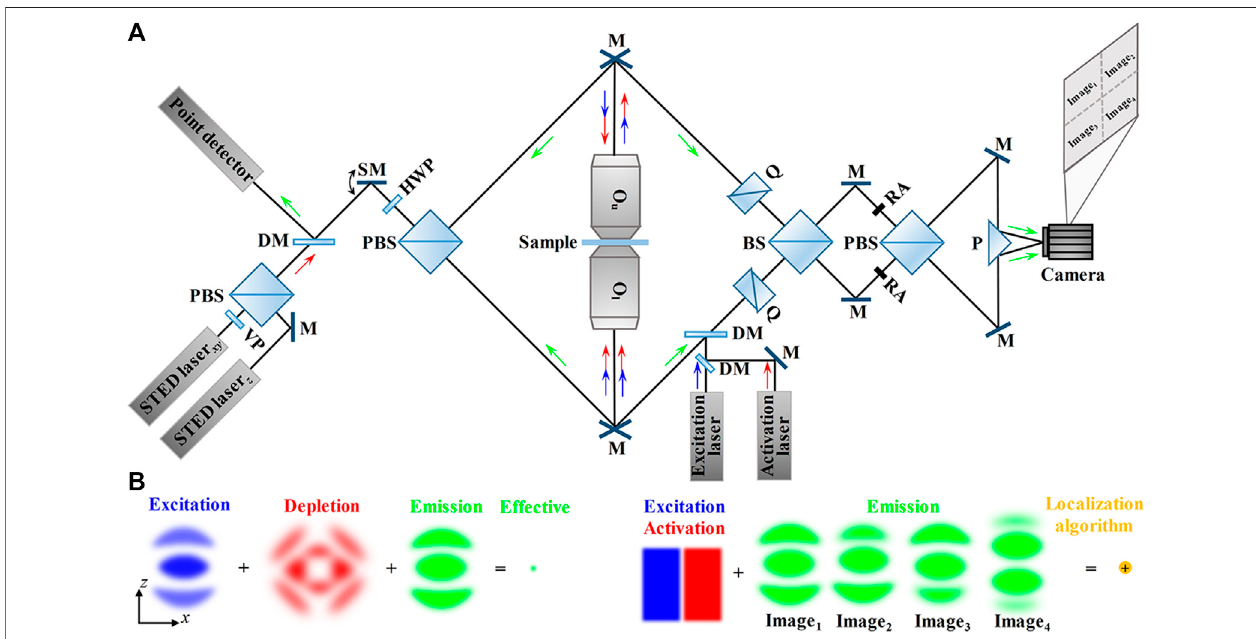
FIGURE6 | Schematic and principle ofdual-lens SRFM methods relying on nanoscopy. (A) Schematic of scanning modality (left, such as isoSTED/4Pi-RESOLFT) and wide fi eld modality (right, 4Pi-SMLM). Left: in isoSTED, the beams for STEDxy (lateral) and STEDz (axial) are combined by a polarizing beam splitter and then fed through ascanning mirror and asecond polarizing beam splitter into the4Picavity.The fl uorescence from the sampleis inversely collected by thesame objective lenses and re fl ected by a dichroic mirror, and fi nally collected by a point detector. Right: in 4Pi-SMLM, the synchronized excitation beam and activation beam are fed into the interference cavity sothat only individual fl uorescence molecules are brightat a time. The fl uorescence isdivided and recombined bya beam splitter and a polarizing beam splitter to create four interference patterns with different phases, and then, the four interference patterns are imaged by the four-quadrant camera simultaneously. (B) PSFsinisoSTED(left)and 4Pi-SMLM(right)intheaxial(xz)plane. Left:theisotropiceffective PSFisobtainedbythesuperimpositionofexcitation PSF,depletionPSF (the superimposition of STEDxy beam and STEDz beam), and emission PSF. Right: the synchronized excitation beam and activation beam make sure only individual fl uorescence molecules are bright at a time. The four emission PSF images obtained by the self-interference of individual fl uorescence molecules are processed by the localization algorithm to localize the individual molecules. Blue and green arrows indicate the directions of the excitation beam and fl uorescence. VP, 0 – 2 π vortex phase plate; DM, dichroic mirror; SM, scanning mirror; Q, quartz wedges; BS, 50/50 beam splitter; PBS, polarizing beam splitter; RA, rectangle aperture; M, mirror; P, prism; Ou, the upper objective lens; O l , the lower objective lens.